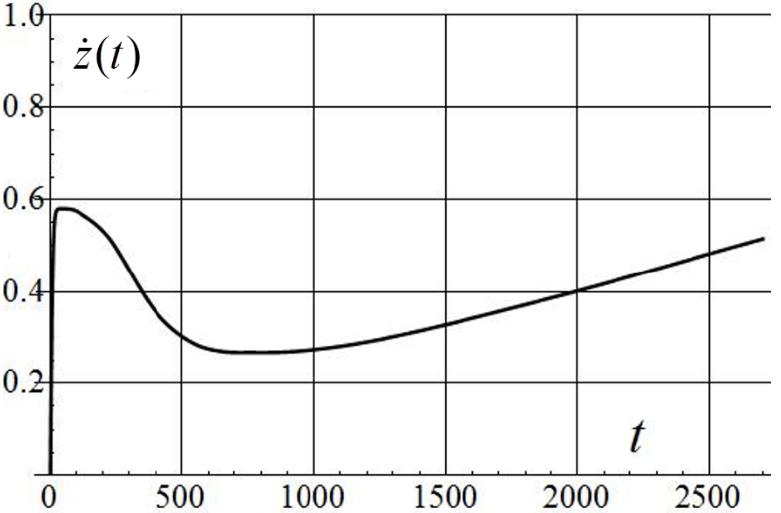
Figure 18 Figure 18.